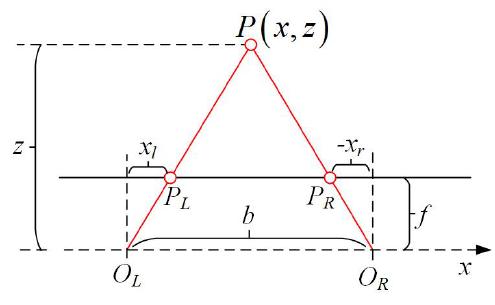
Figure 10. The principle of the binocular camera distance measurement